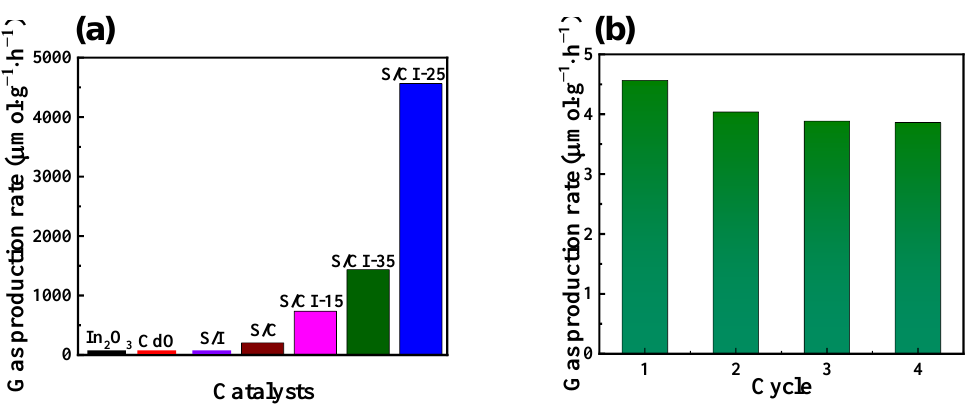
Figure 5. ( a ) H 2 evolution rates of the as-synthesized photocatalysts and ( b ) recycling tests of photocatalytic H 2 evolution rates over S/CdO@In 2 O 3 -25.